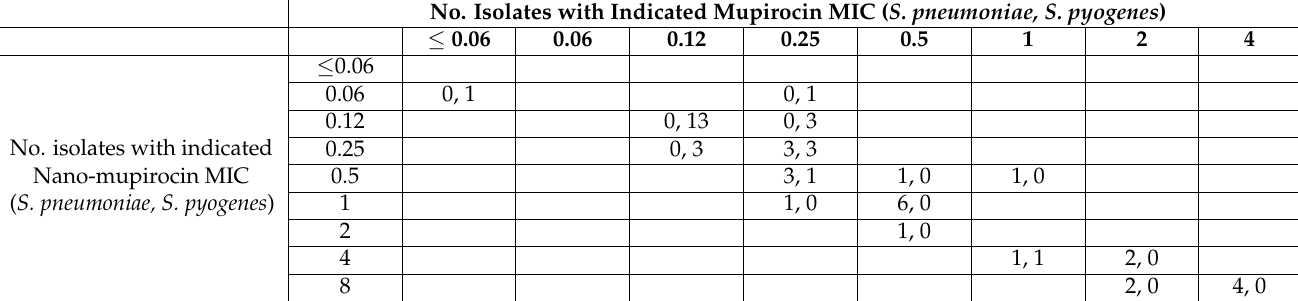
Table 2. Mupirocin and Nano-mupirocin MICs for S. pneumoniae ( n = 25) and S. pyogenes isolates ( n =